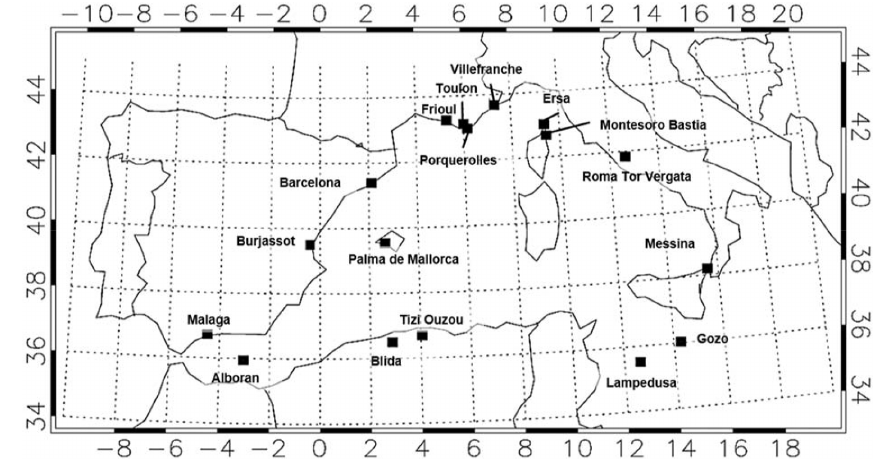
Figure 1. Map of the locations of the 17 AERONET ground-based stations considered in this